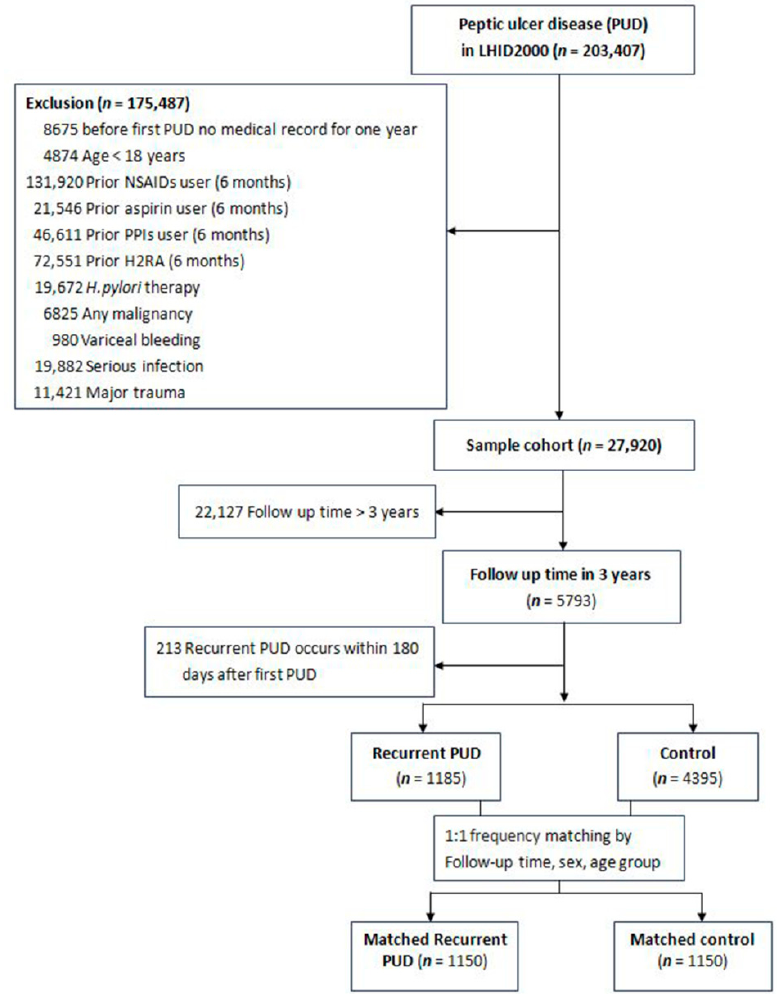
Figure 1. Flowchart depicting participant selection.